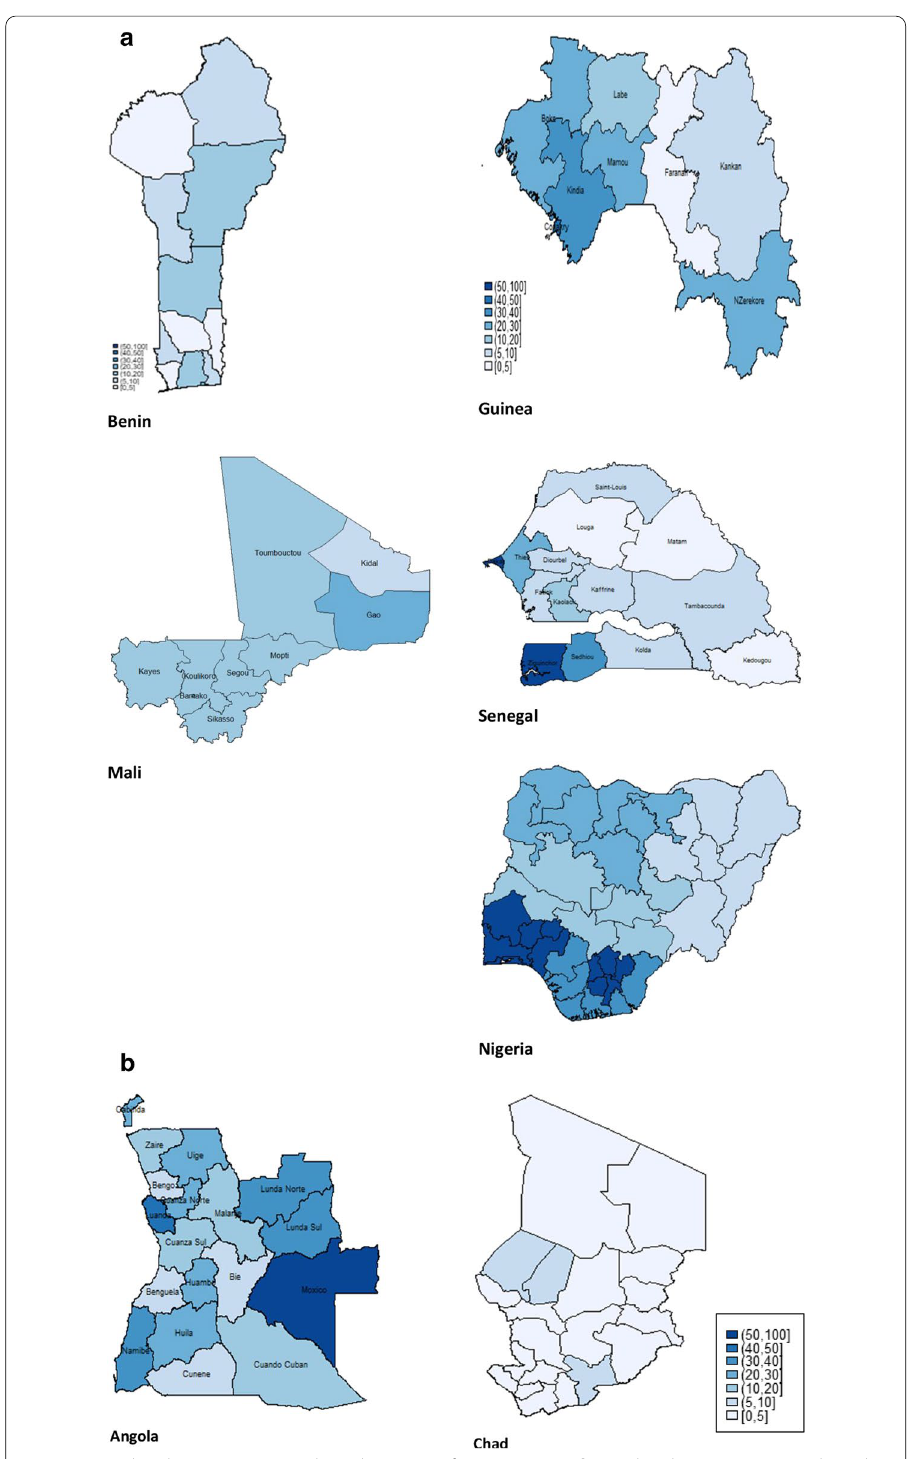
capacity in selected Southern Africa